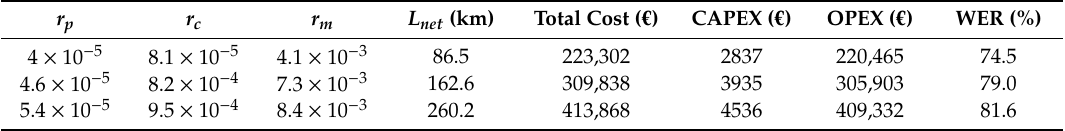
Table 8. Trade-o ff solutions with regard to considered constraints and